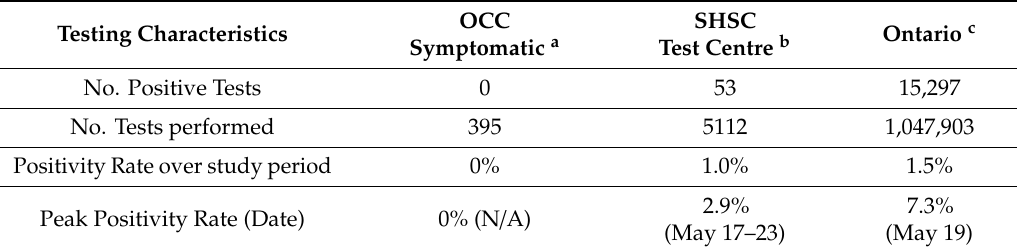
Table 2. A summary of the positive testing rate at three di ff erent testing sites over the time period